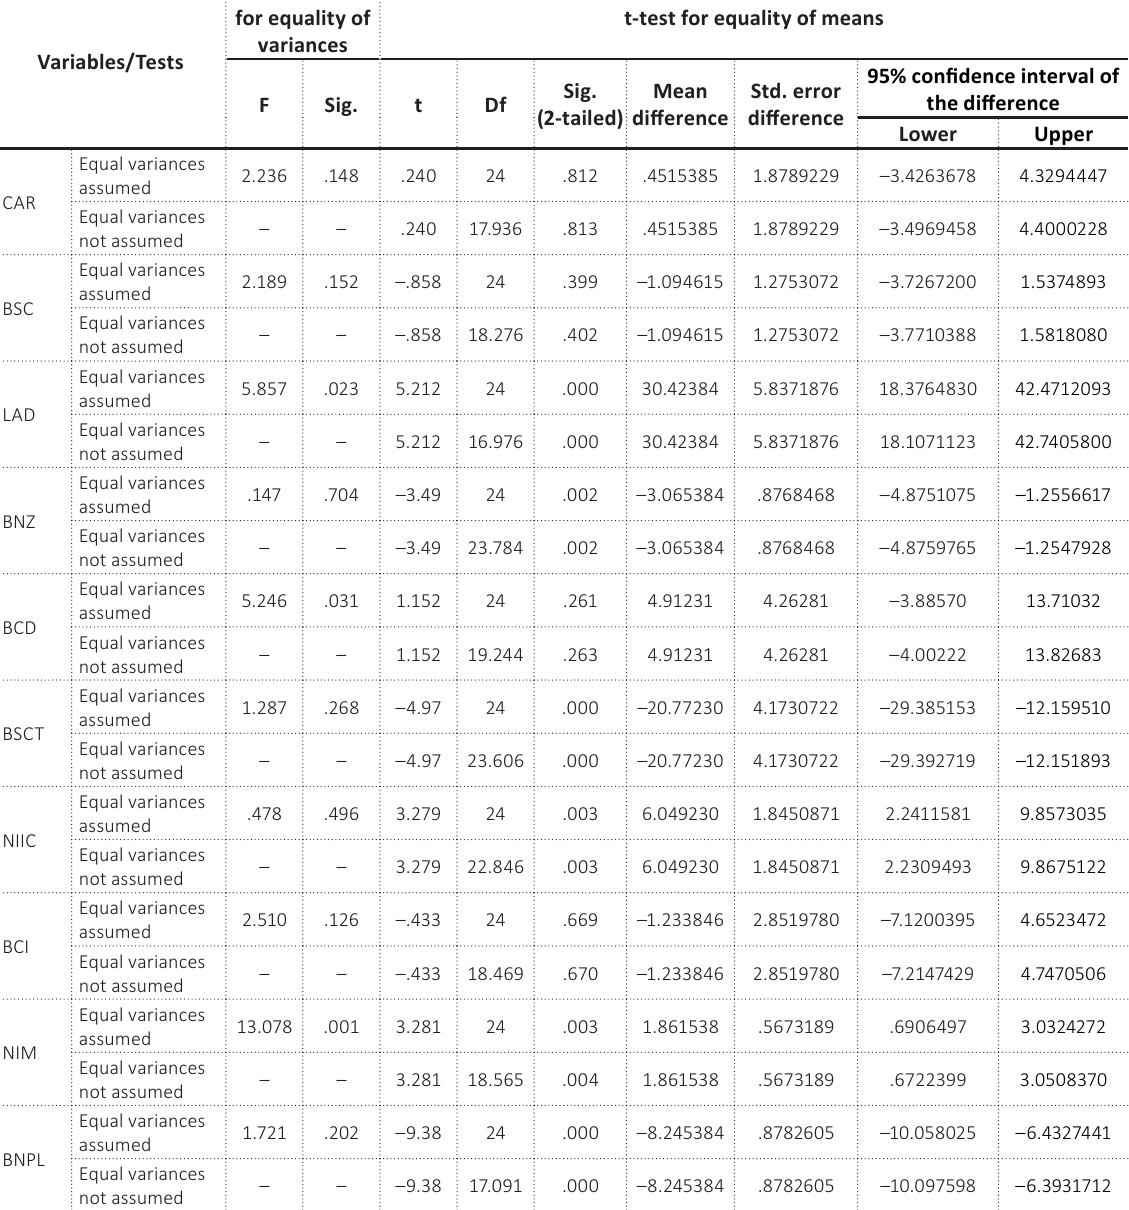
Table 3. Levene’s test for equality of variances and independent sample t-test for equality of means